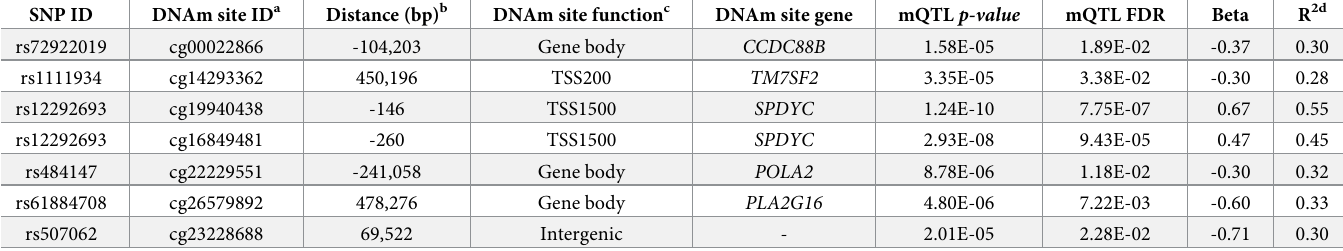
a DNAm site identificator b SNP-DNAm site genetic distance.